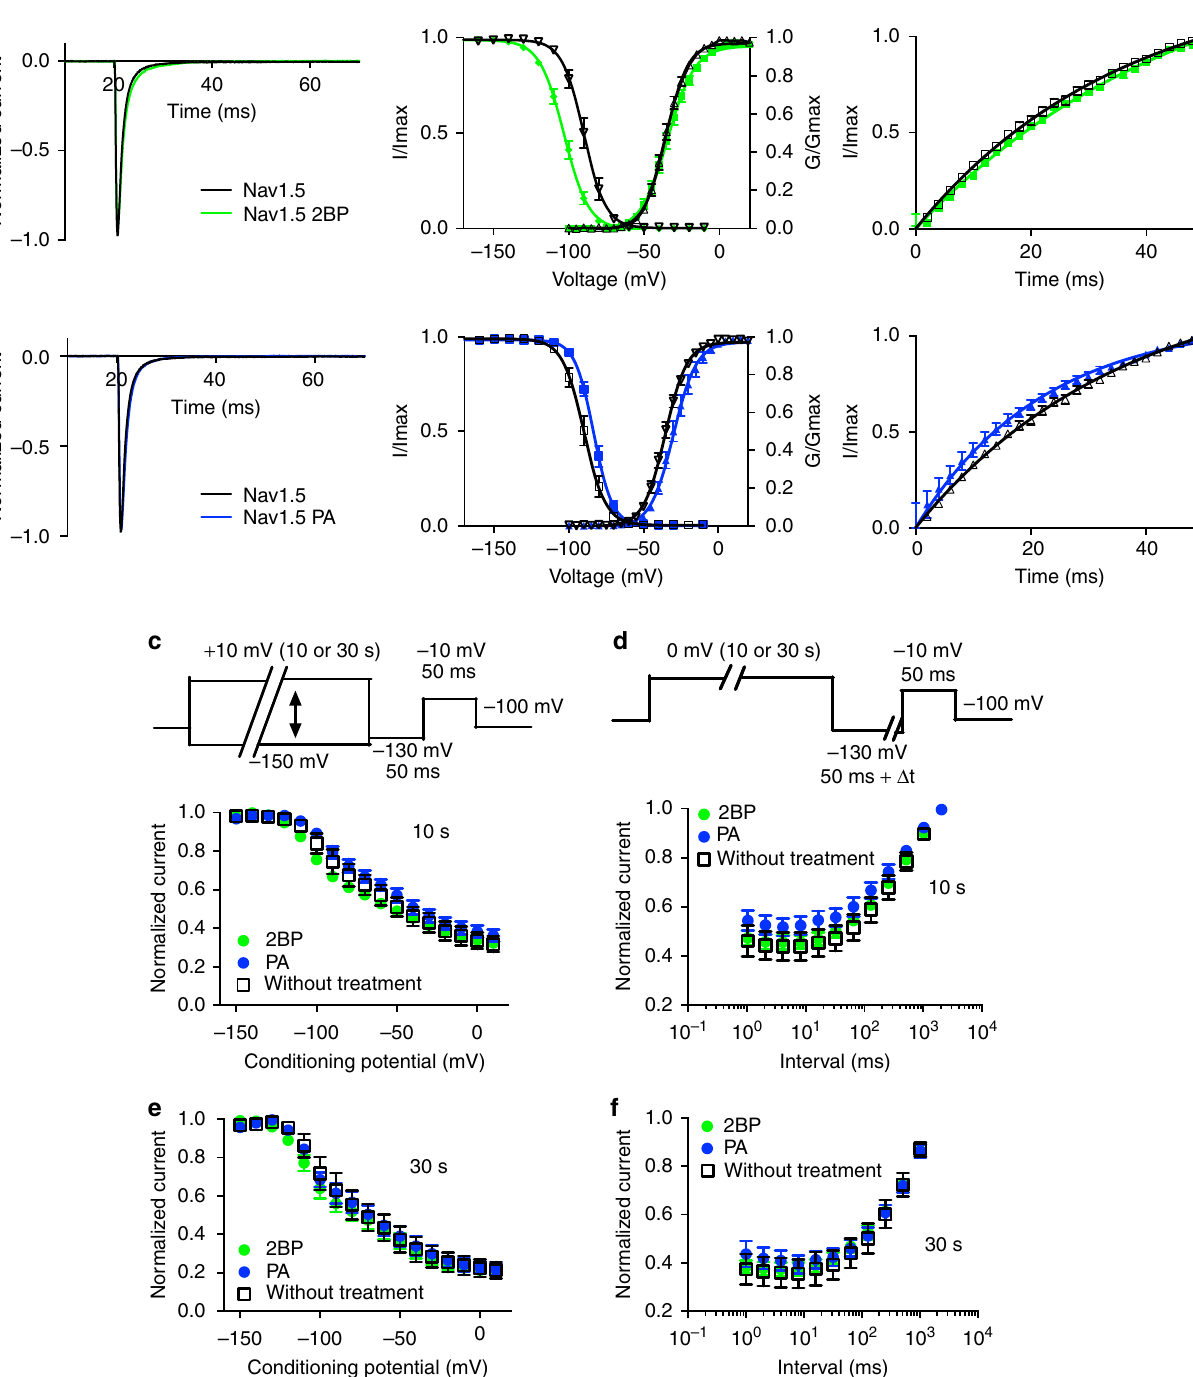
Figure 5 | 2-Br-palmitate(2BP) and palmitic acid(PA) treatments alter Nav1.5 biophysical properties in HEK293 cells. 2-Br-palmitate treatment group data are shown in green and palmitic acid treatment group data are shown in blue. Control conditions are shown in black lines and open symbols. All data are shown as mean ± s.e.m. ( a , b ) Left: normalized currents of Nav1.5 compared with 2-Br-palmitate/palmitic acid treatments. Channels were depolarized to (cid:2) 20mV from a holding potential of (cid:2) 100mV. Middle: voltage dependence of activation and steady-state inactivation of the channel. Right: Nav1.5 recovery from inactivation. n ¼ 11. ( c , e ) 2-Br-palmitate and palmitic acid treatment does not affect Nav1.5 voltage dependence of slow inactivation (( c )10s; ( e )30s; n ¼ 8). ( d , f ) 2-Br-palmitate and palmitic acid treatment does not affect Nav1.5 recovery from slow inactivation (( d )10s; ( f ) 30s; n ¼